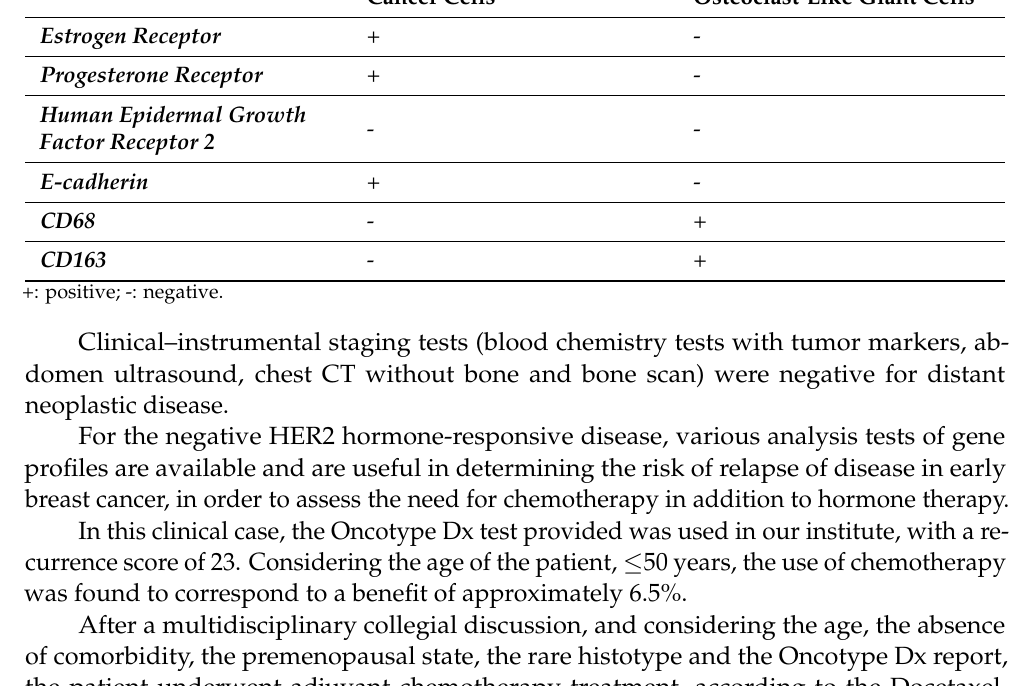
Table 1. Immunohistochemical findings in invasive ductal carcinoma of the breast with osteoclast-like giant cells. Cancer Cells Osteoclast-Like Giant Cells Estrogen Receptor + - Progesterone Receptor + - Human Epidermal Growth - Factor Receptor 2